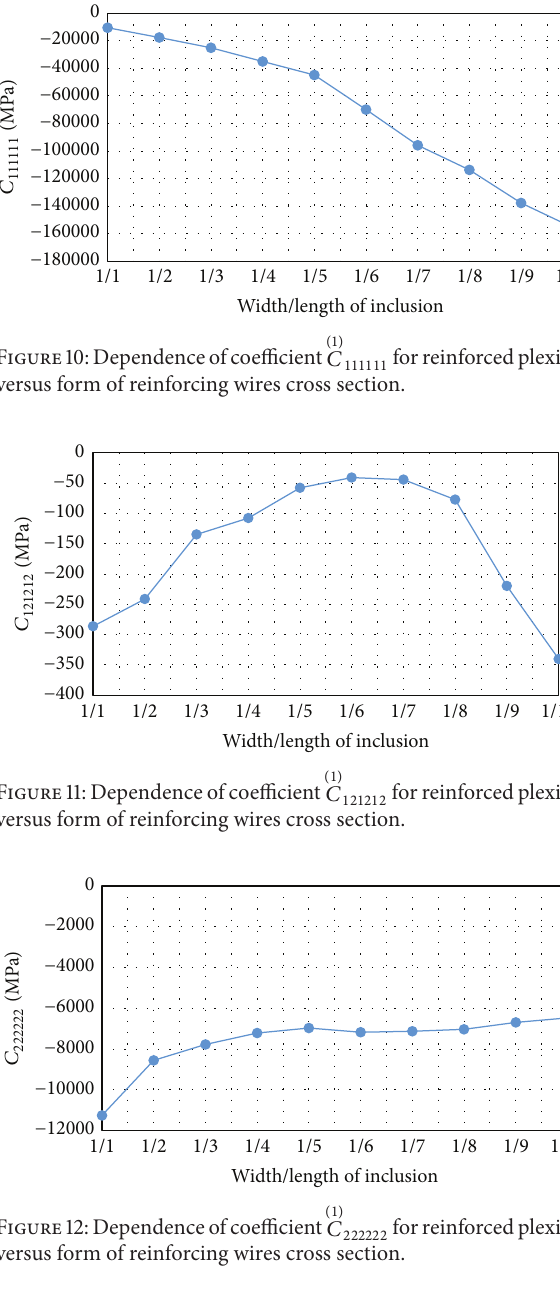
Figure12:Dependenceofcoefficient versus form of reinforcing wires cross